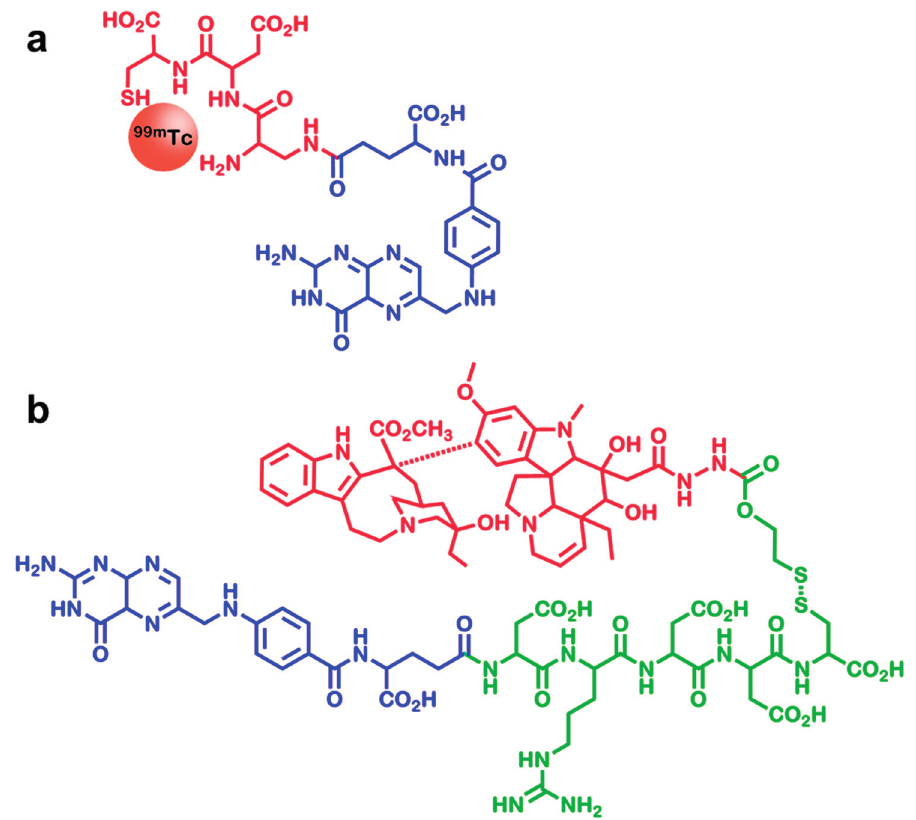
Figure 6. ( a ) Chemical structure of etarfolatide. It is used to image folate receptor